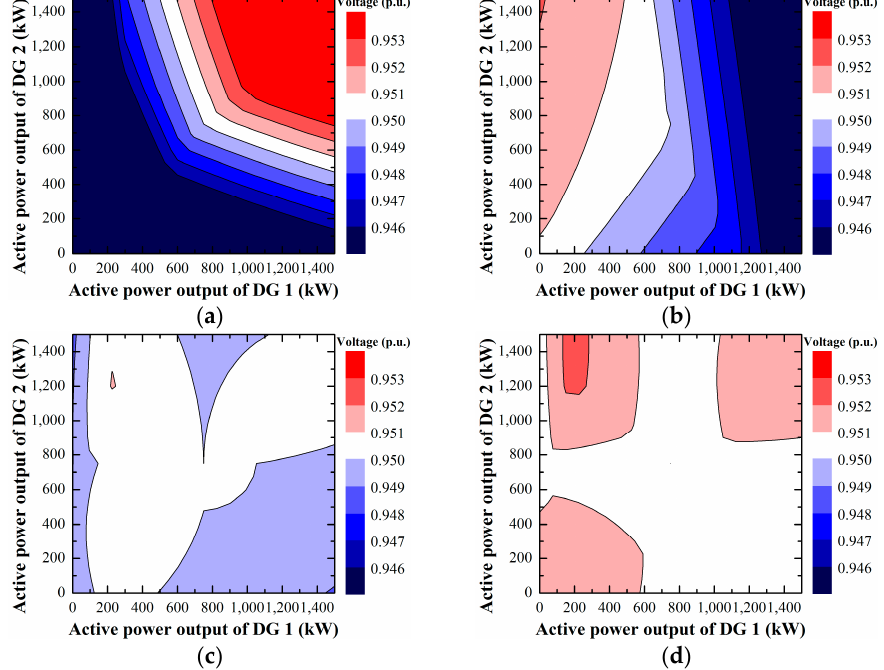
Figure 9. Contours of the minimum voltage ( QP : two-segment Q – P droop control), ( a ) fixed reactive power; ( b ) fixed voltage; ( c ) QP w/ initial droop constant; ( d ) QP w/ final droop constant.